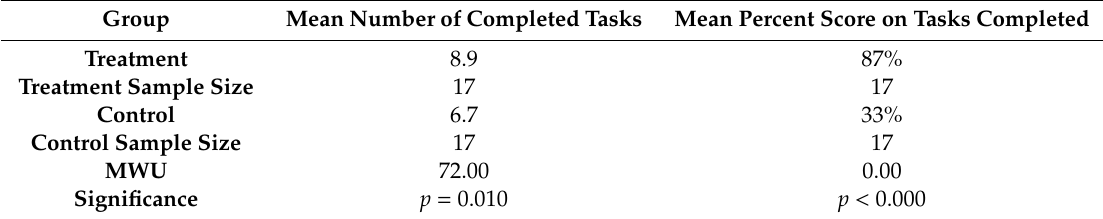
Table 1. Overall achievement results.